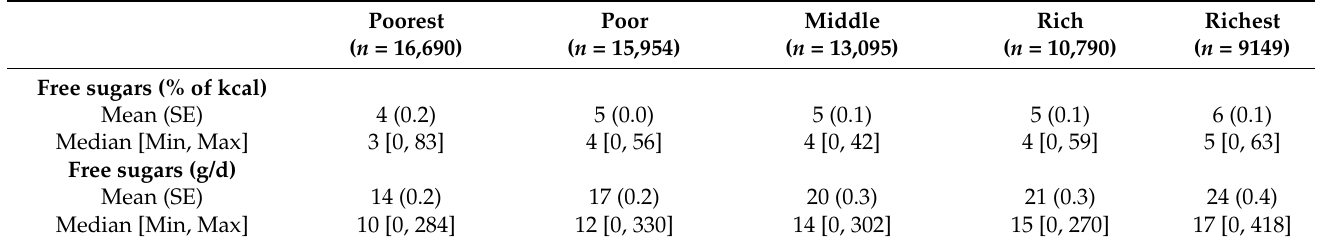
Table 10. Intakes of free sugars by wealth status.